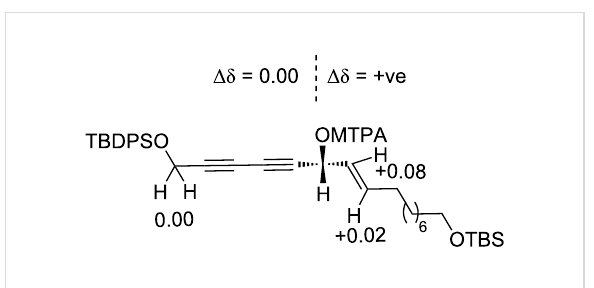
Figure 2: Absolute configuration analysis of alcohol 25 . ∆δ = δ S − δ R for the ( R )- and ( S )-MTPA ester of alcohol 25